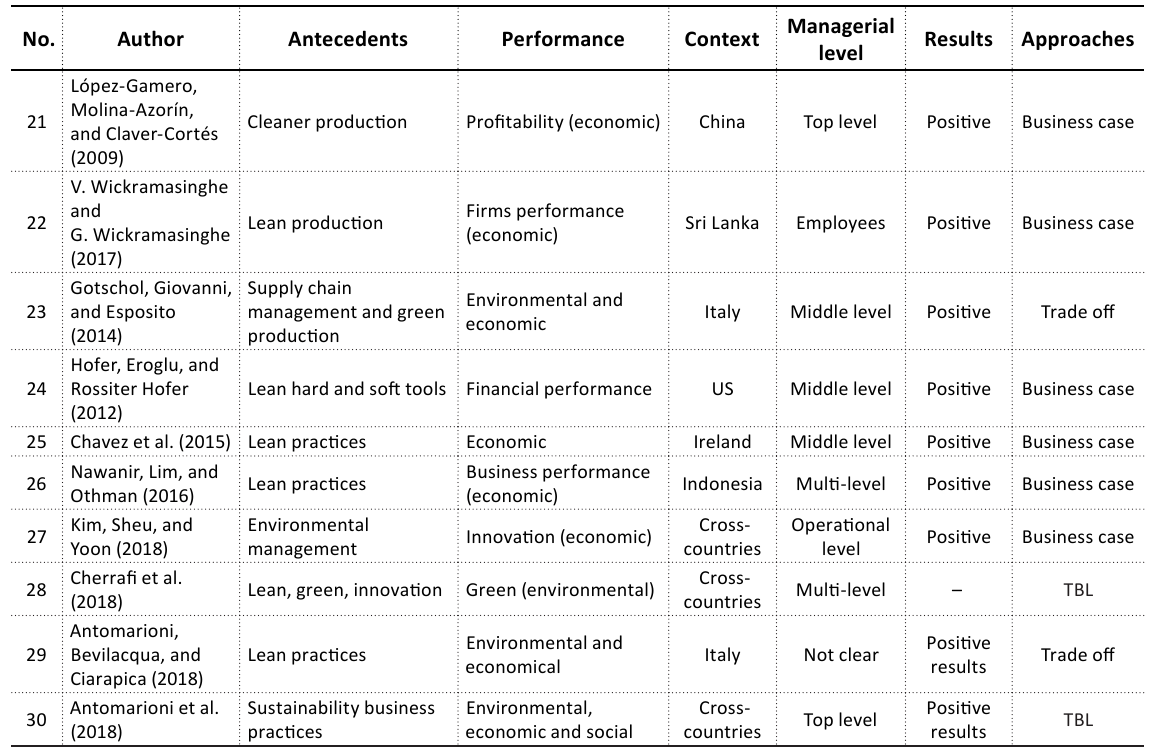
Table A1 (cont.). The description of sustainability performance, antecedents, approaches, country context and managerial